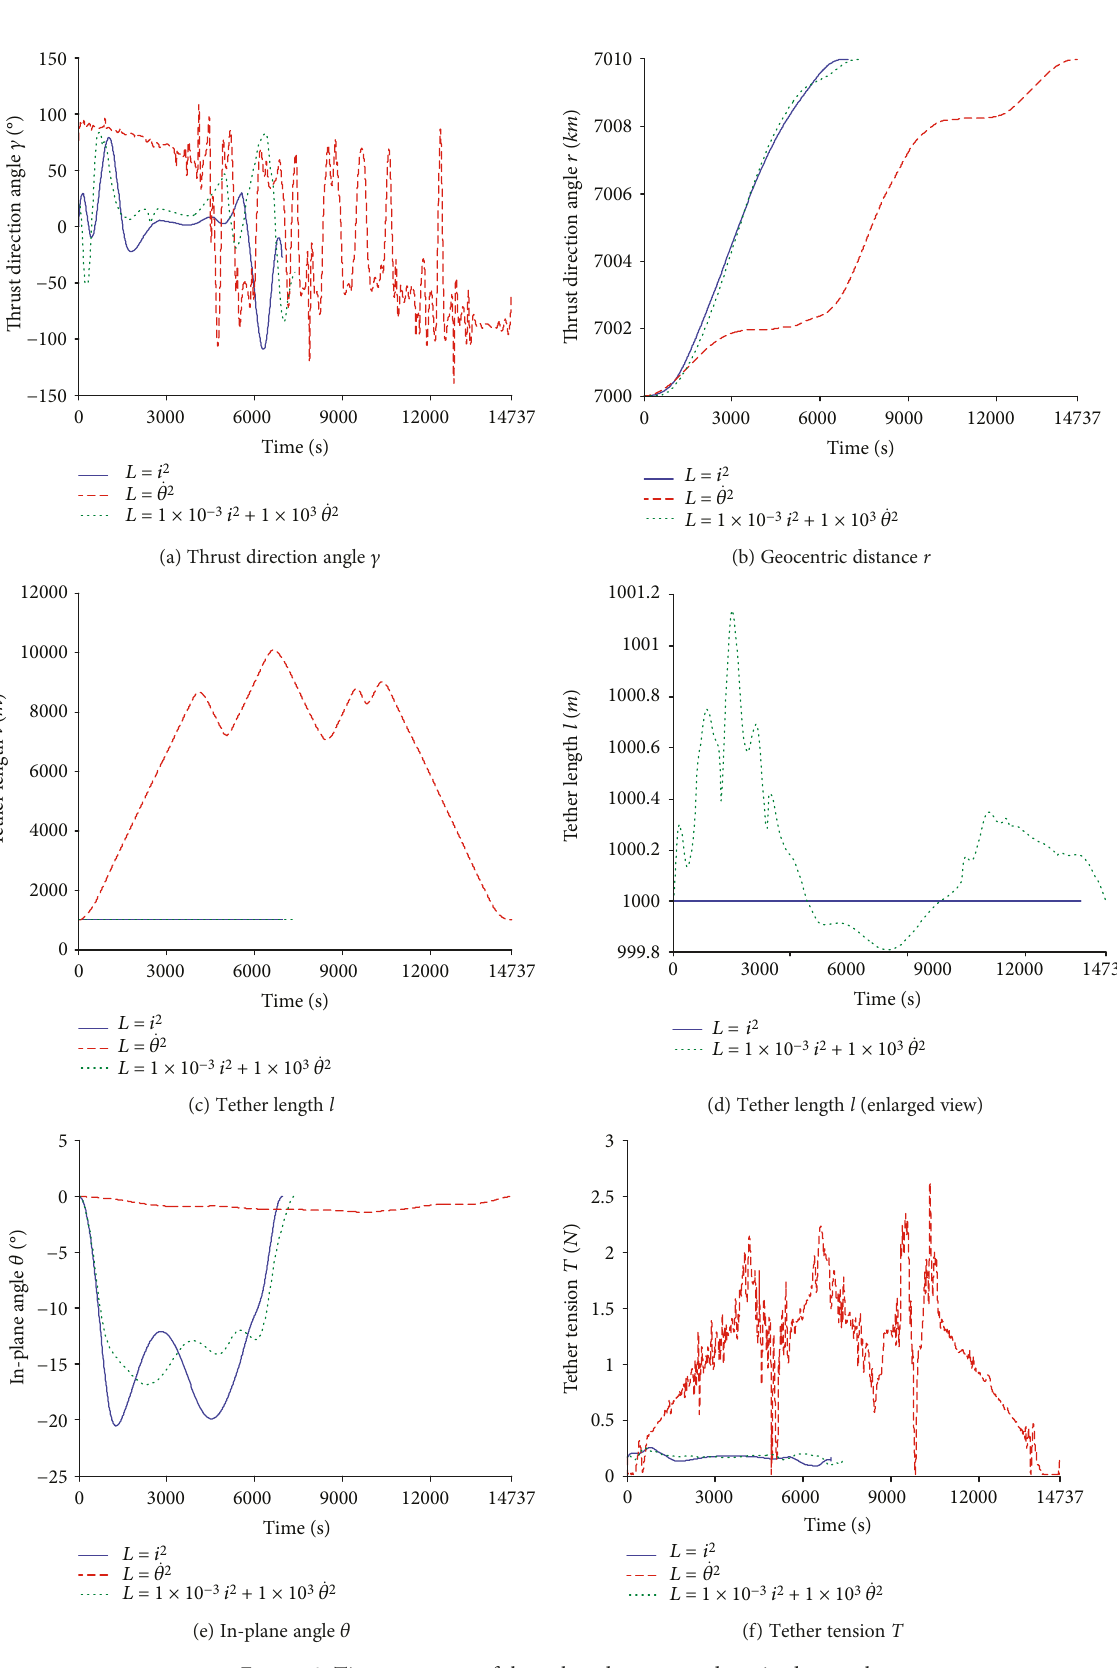
Figure 8: Time responses of the tethered system under mixed